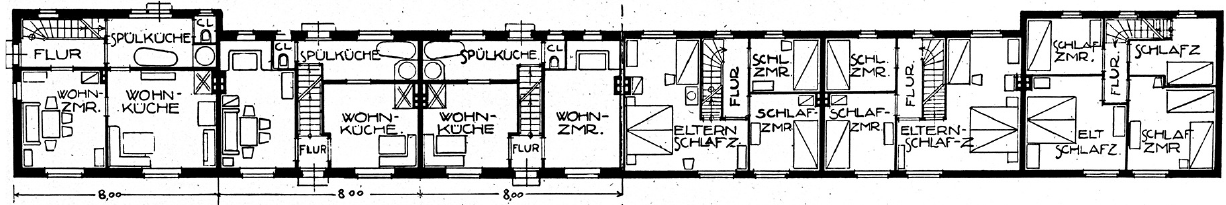
Figure 8. Muthesius’ floor plans for a housing group in Hellerau, 1909. From the collection of Franz Stoedtner. Source: “Grundriß der Häusergruppe ”Beim Gräbchen” in Hellerau” [Plan of a housing group “Beim Gräbchen” in Hellerau] (1909), © Bildarchiv Foto Marburg.